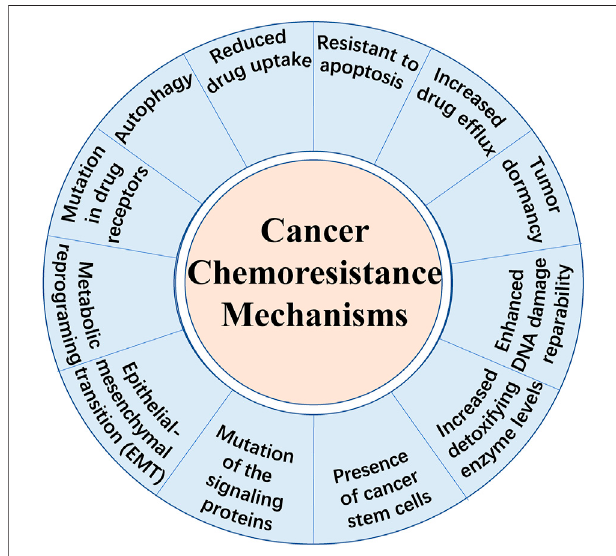
FIGURE 1 | Schematic representation of the main mechanisms of chemoresistance in cancer cells.